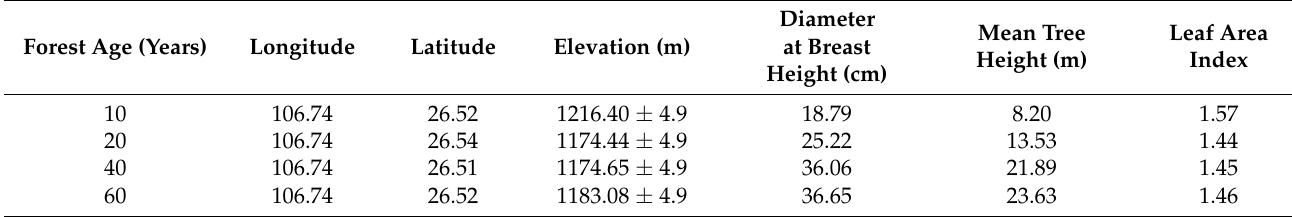
Table 1. Basic information of the sample